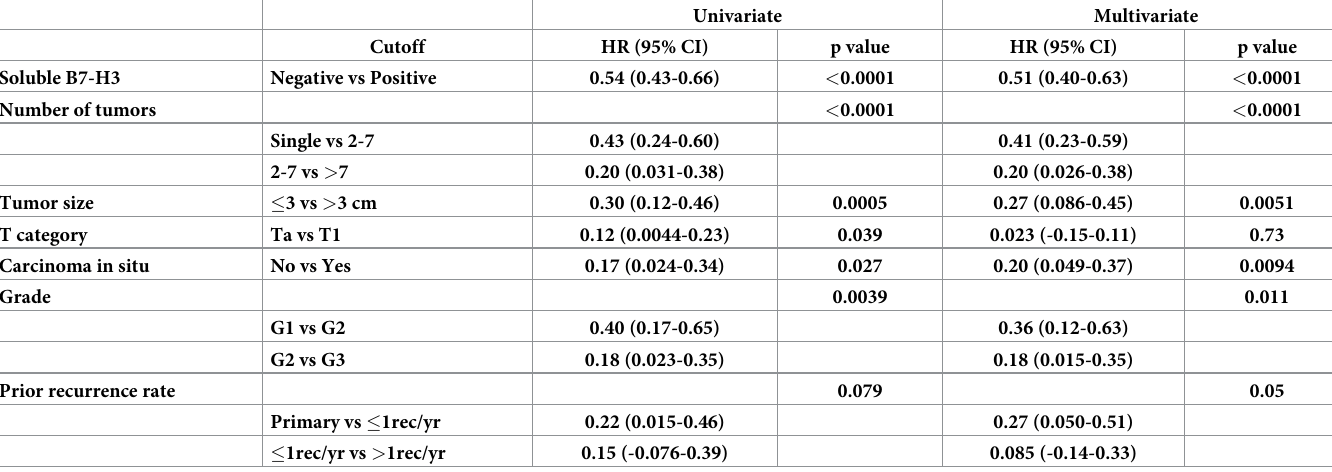
Table 3. Univariate and multivariate analysis of recurrence.